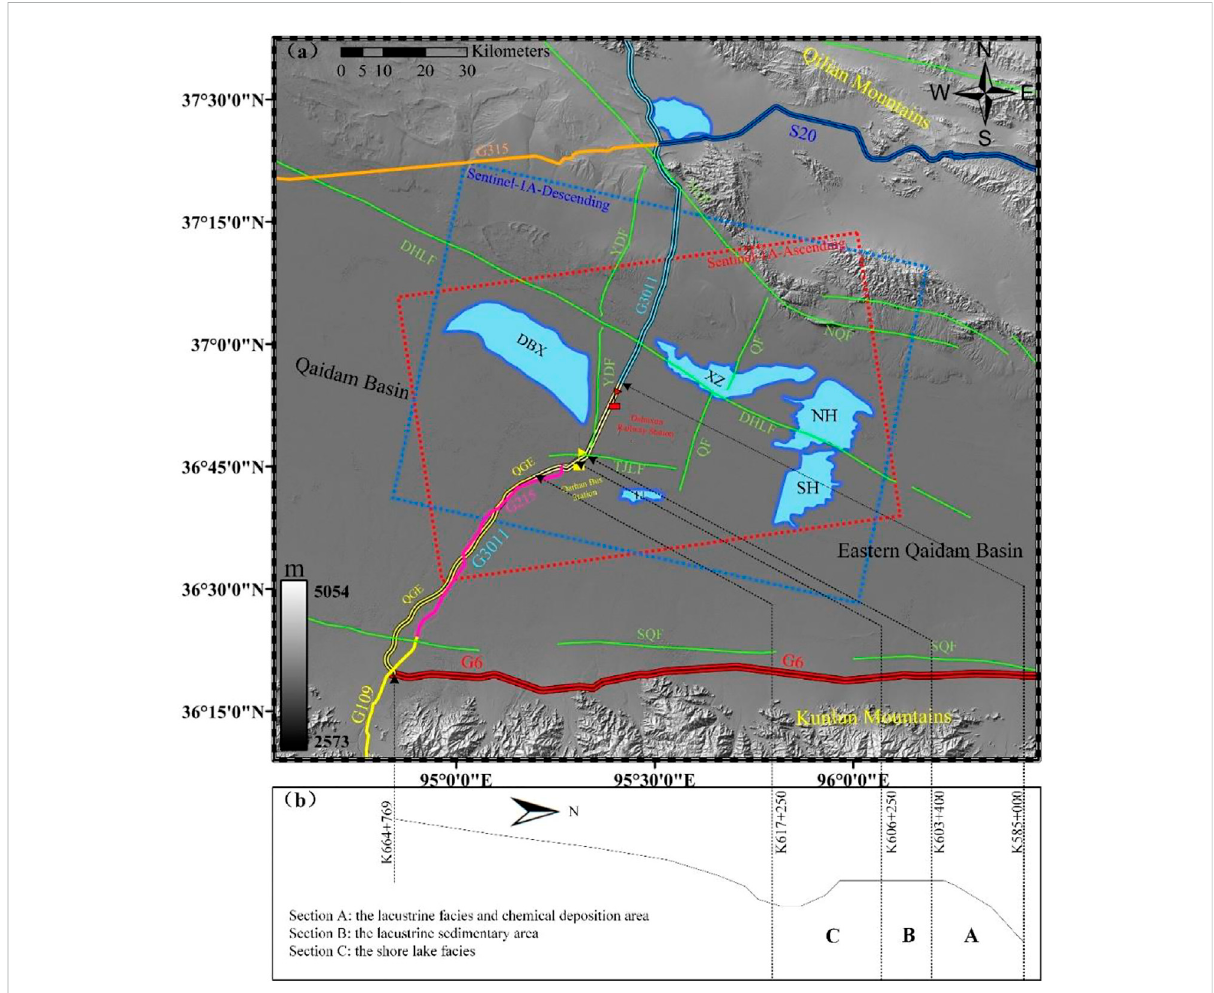
FIGURE 1 (A) Tectonic map of the study area. The blue and black, red and black, and yellow and black lines indicate the G3011 (Liuyuan – Golmud Expressway, LGE), the G6 (Beijing – Tibet Expressway, BTE), and the QGE (Qarhan – Golmud Expressway),respectively. The yellow,purple,and brown lines denote the G109, G215, and G315, respectively. The blue and red rectangles mark the coverage of the descending and ascending Sentinel-1A images. The blue polygons represent the DBX (Dabuxun lake), XZ (Xiezuo lake), TJ (Tuanjie lake), NH (North Huobuxun lake), and SH (South Huobuxun lake), respectively. The green lines denote the faults in this area, including NQF (North Qaidam Fault), SQF (South Qaidam Fault), TJLK (Tuanjian Lake Fault), QF (Qarhan Fault), YDF (Yaxi – Dadong Fault), and DHLF (Dabuxun – Huobuxun Lake Fault). The red and yellow fl ags indicate